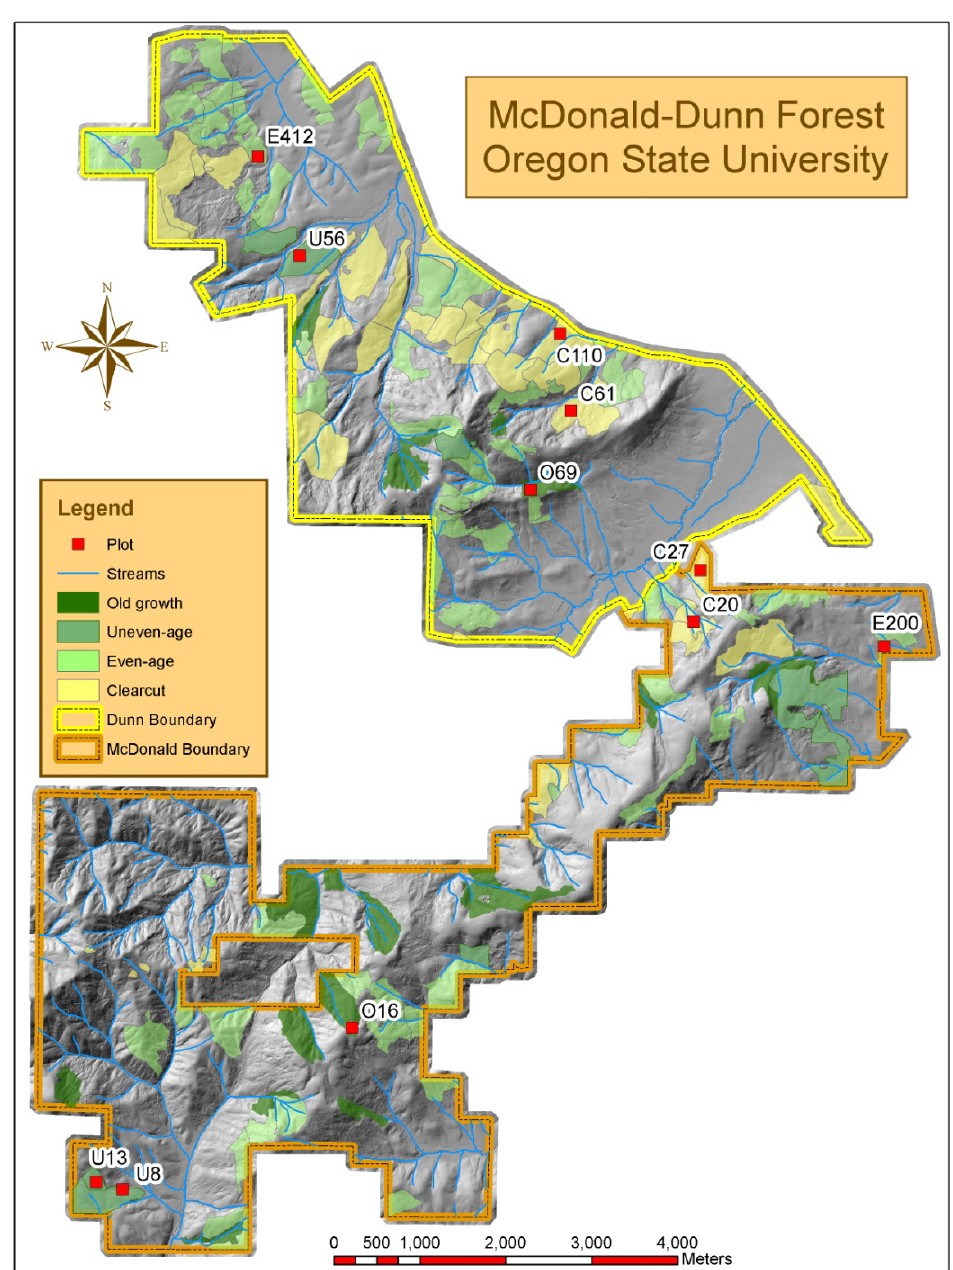
Figure 2. Plot locations in McDonald-Dunn